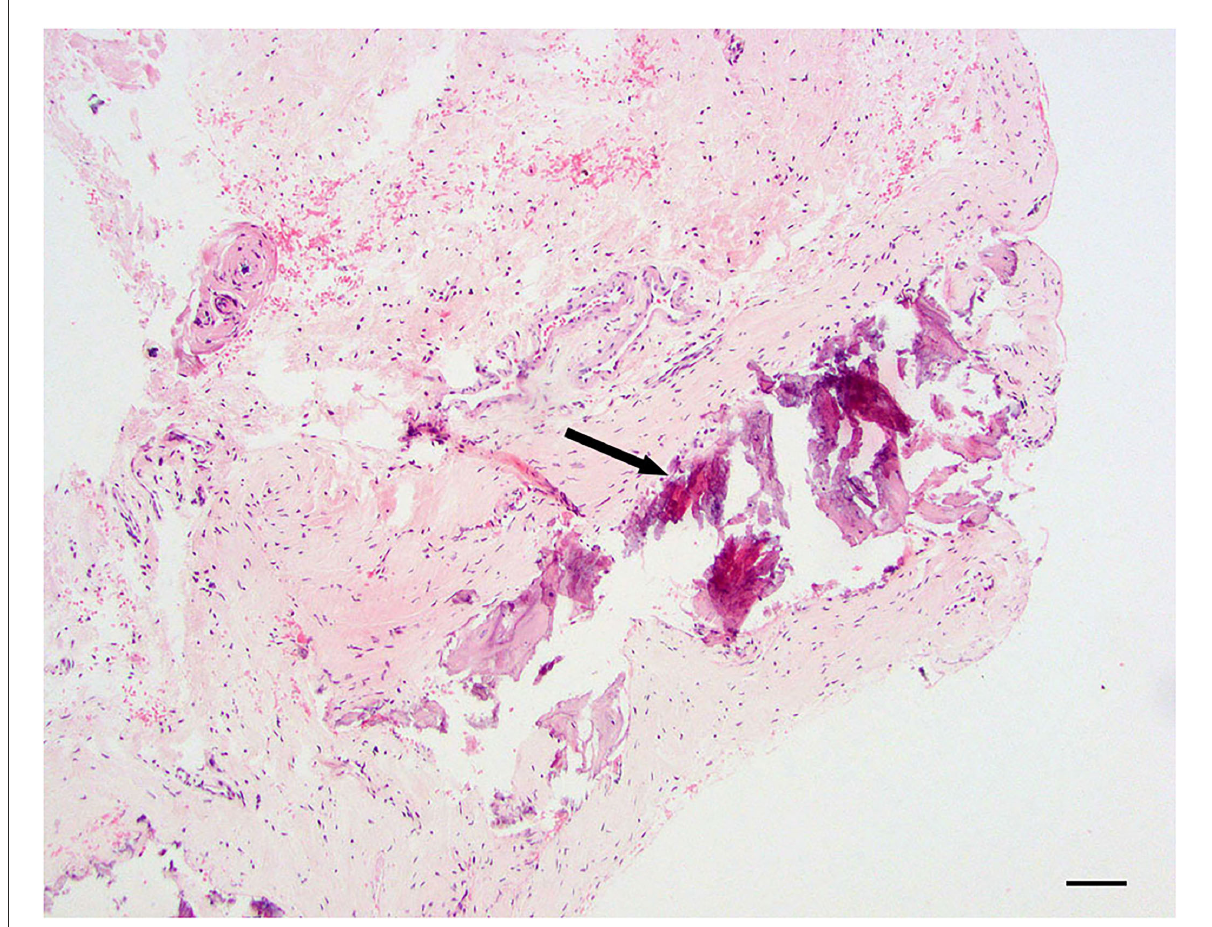
FIGURE4 Dural mineralization; 20 × –Scale bar = 50 microns; Arrow indicated